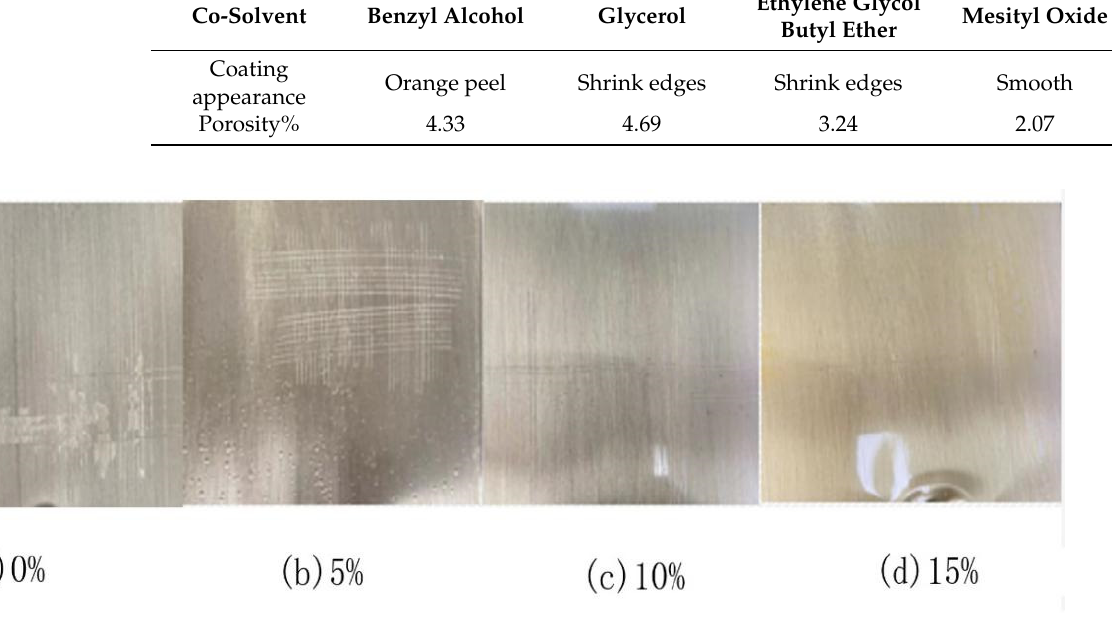
resulting in an uneven coating surface and poor adhesion. Although the adhesion